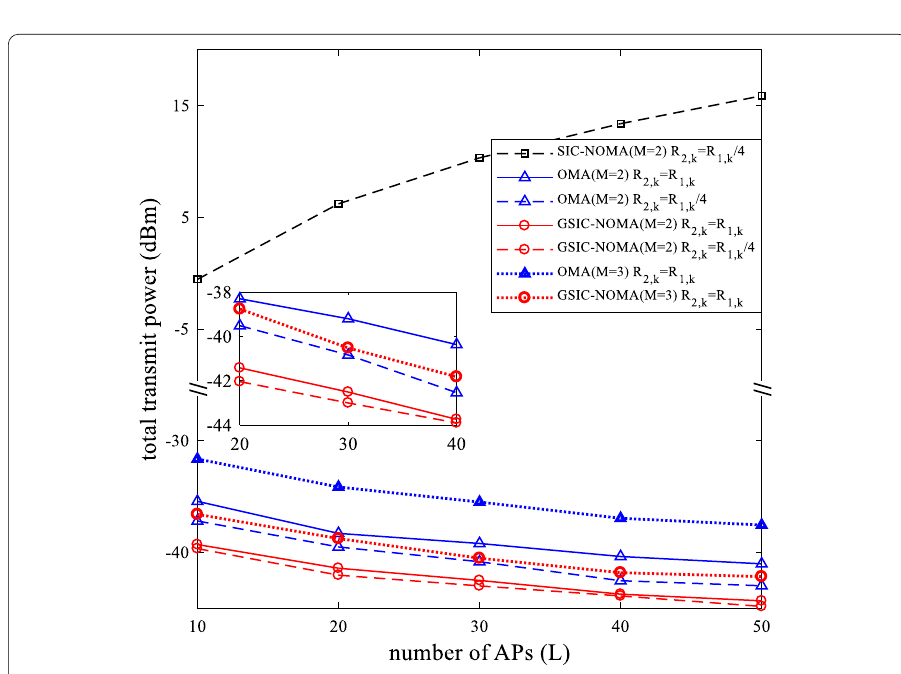
Fig. 3 Total transmit power versus the minimum rate